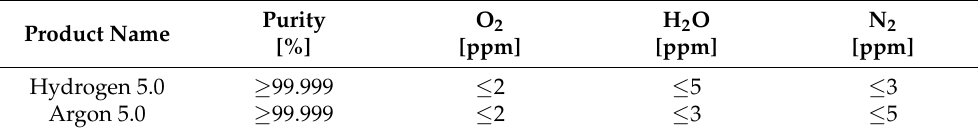
Table 2. Purity and residuals of the process